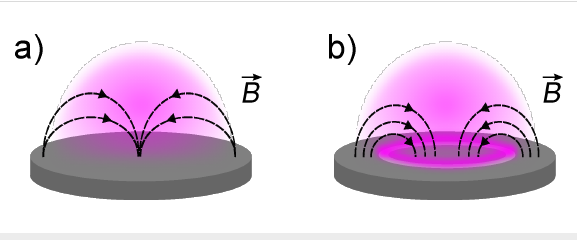
Figure 4: Erosion of the target is found to affect particle sizes and structure. Schematic of the sputtering target a) fresh planar target, b) eroded target eventually generating an increase in plasma density, sputter yield and temperature in the vicinity of the racetrack.